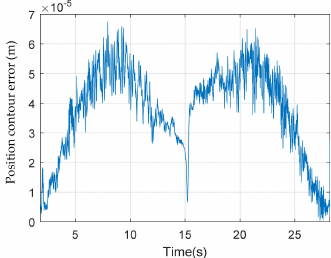
Figure 11. Experimental results: the position contour errors.